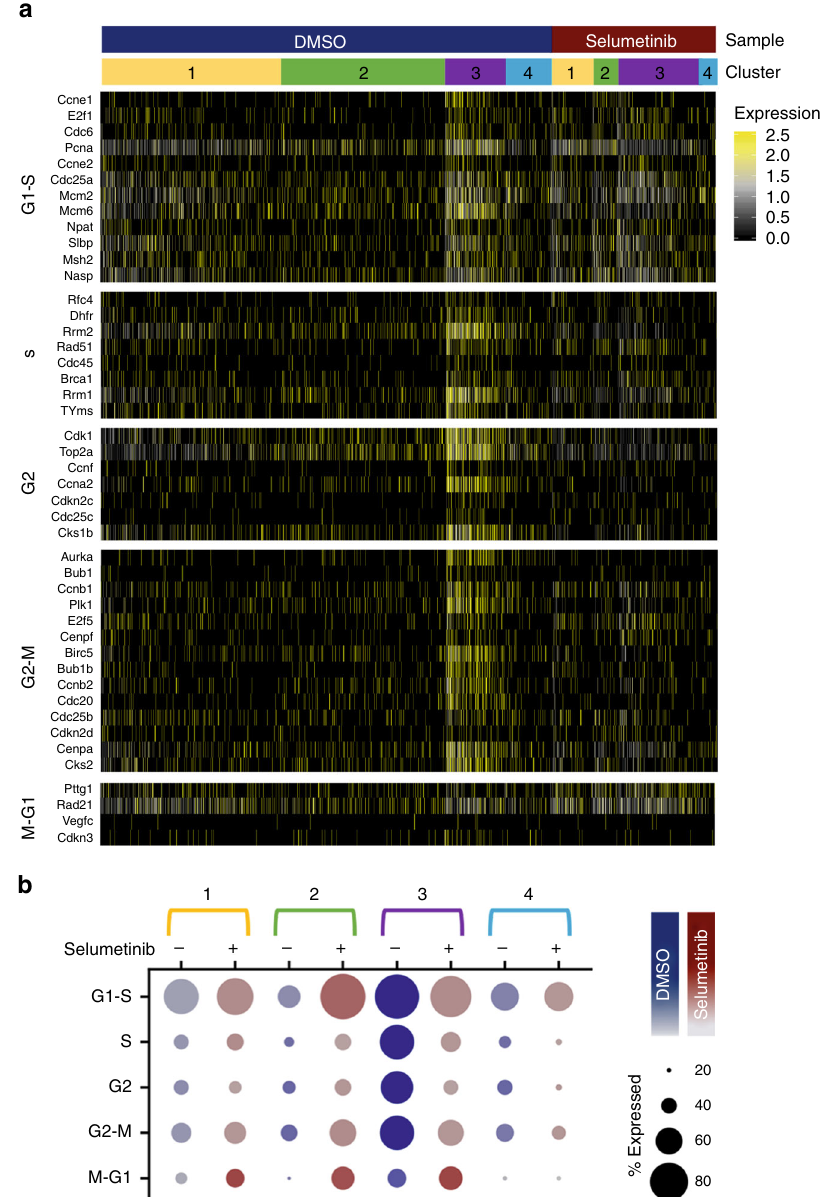
Fig. 7 Cell cycle state in Meta4 cells treated with either DMSO or Selumetinib. a Heatmap of cell cycle genes categorized by phase in DMSO vehicle- treated and Selumetinib-treated Meta4 samples. Rows correspond to individual genes and columns are individual cells, arranged by sample and matched subpopulations. Yellow corresponds to high expression, gray corresponds to neither high nor low expression, and black corresponds to low expression. b Dot plots showing cell cycle meta-genes for each cell cycle phase. Results are shown for matched subpopulations (1 – 4) and split by treatment (DMSO vehicle or Selumetinib). The dot size represents the percent of cells within the matched subpopulation with detected expression of the gene and color intensity re fl ects the average expression in those cells with detectable gene